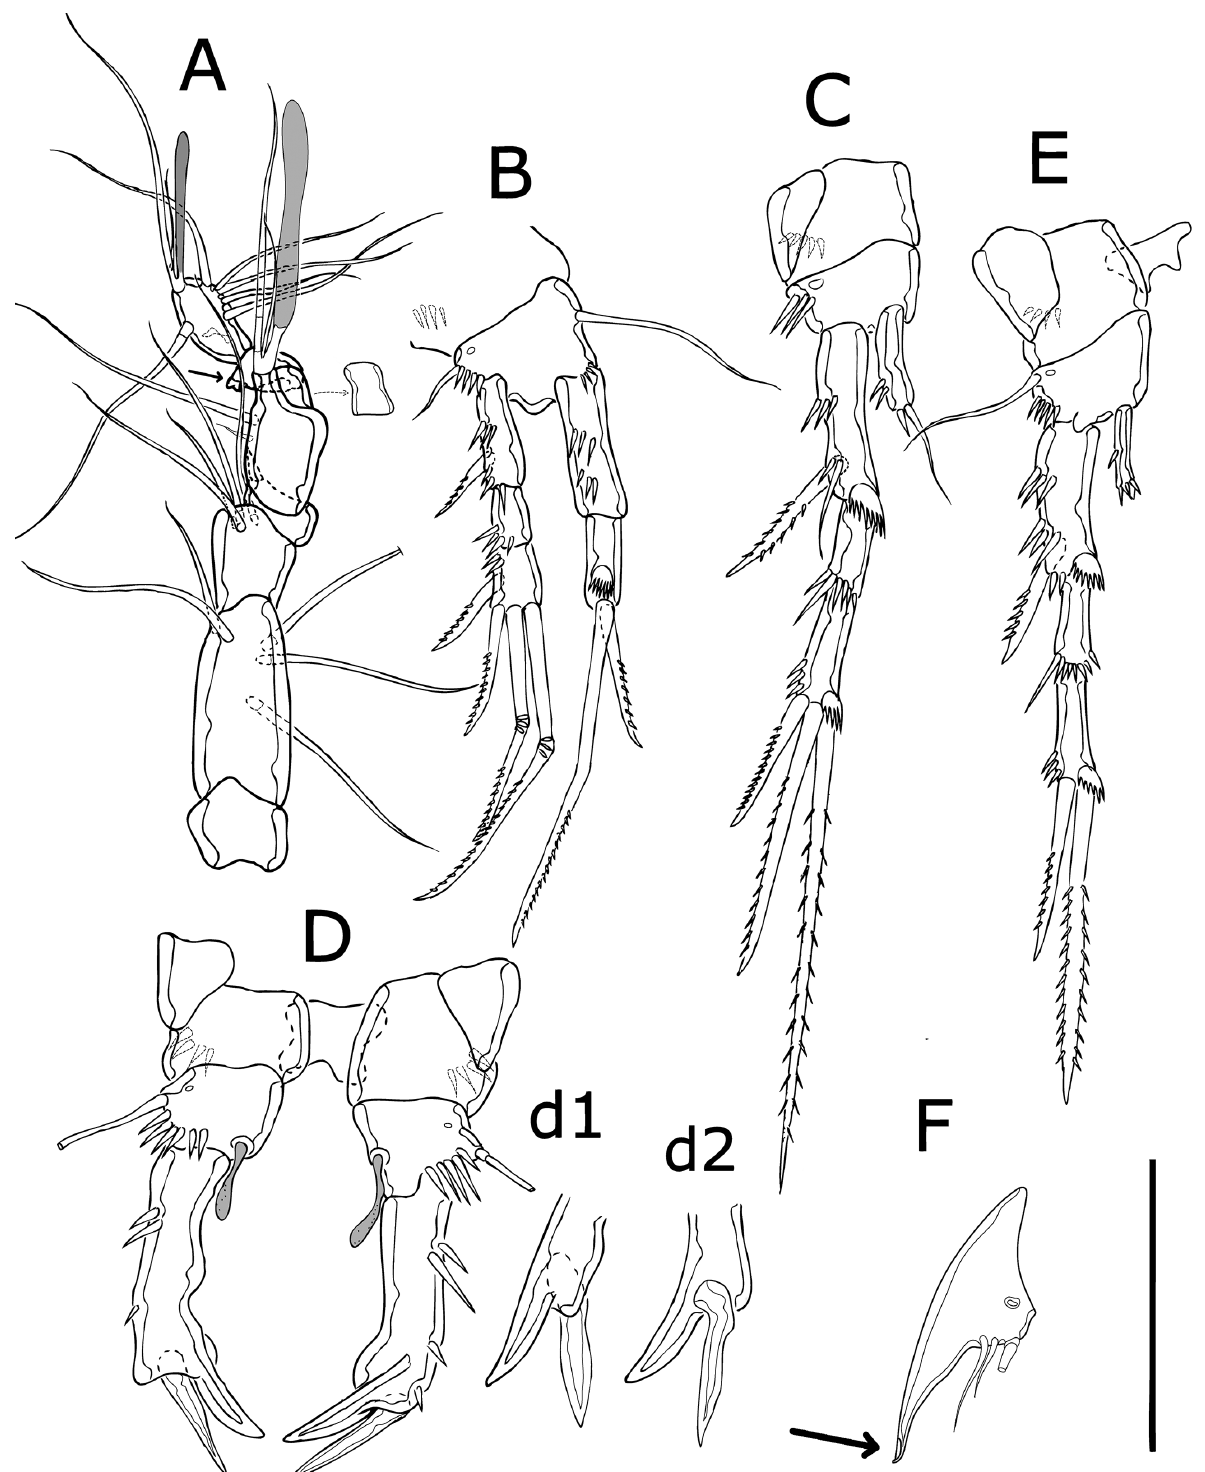
Figure 3. Eirinicaris antonioi sp. n. Male: A antennule, with process arrowed on segment seven, segment six laterally detached; B P1, anterior; C P2, anterior; D P3, anterior; d1 distal part of exopod of P3 showing the apophysis, anterior; d2 distal part of exopod of P3 showing the apophysis, posterior; E P4, anterior; F P5, with distal pore arrowed. Scale bar = 25µm. P4 as in Figs 3E, 7B. Coxa with posterior row of tal spinules and one medial outer spinule; exp 3-segment- spinules; basis with outer pore, outer seta, and row of out- ed, exp-1 with long outer spine, ornamented with row of er spinules close to exp; enp cylindrical, with accuminate spinules proximally and subdistally, with comparatively tip, approximately half the length of exp-1, with three dis- smaller distal spinules, and inner hyaline frill; exp-2